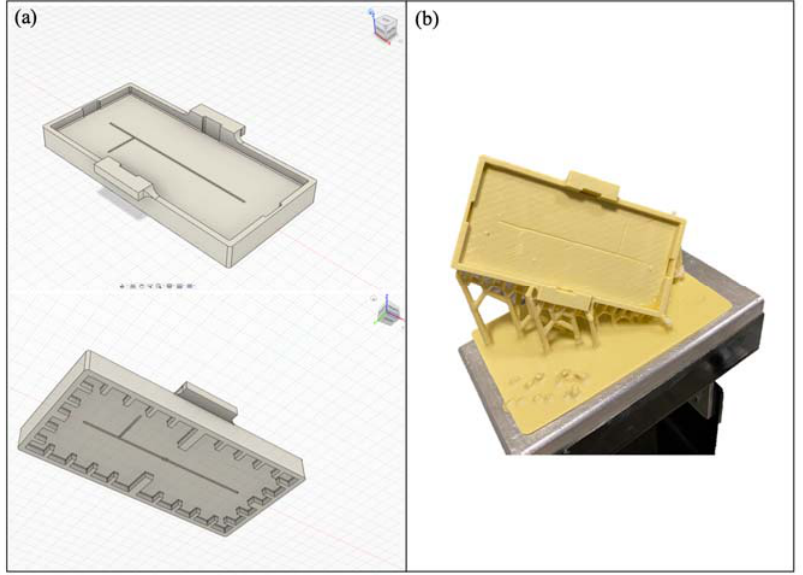
Figure 1. Customized mask for the PDMS device design using Autodesk ® Fusion 360 ( a ); 3D printed mask ( b ).